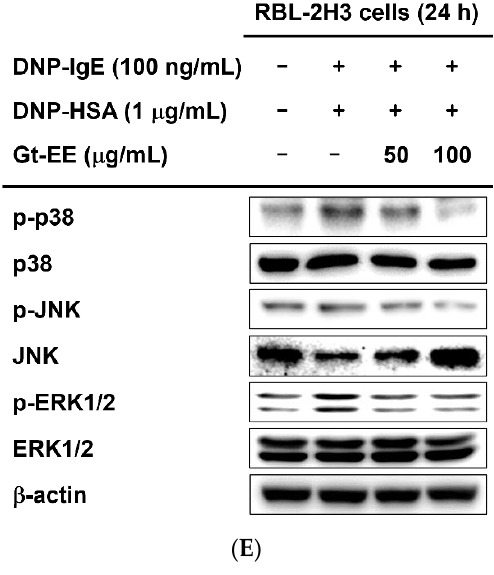
Figure 2. Gt-EE suppressed the mRNA expression of allergic cytokines and activation of the IgE – FcεRI signaling pathway. ( A,B ) The mRNA expression levels of IL- 1β, IL -4, IL-5, IL-6, IL-13, TNF- α, MCP -1, TSLP, and TGF- β1 in IgE-stimulated RBL-2H3 cells were investigated using real-time PCR. IgE-sensitized RBL-2H3 cells were treated with Gt-EE for 30 min and then challenged with DNP-HSA for 24 h. ( C – E ) The total or phosphorylated forms of Syk, PLCγ1, PKCδ, PI3K, AKT, NF - κB p65 , NF- κB p50, p38, JNK, and ERK1/2 in IgE -stimulated RBL-2H3 cells were detected using an immunoblotting analysis. IgE-sensitized RBL-2H3 cells were treated with Gt-EE for 30 min and then stimulated with DNP-HSA for 24 h. ( A , B ) The results are expressed as mean ± standard deviation. ## p < 0.01, ### p < 0.001 compared with the normal group, and * p < 0.05, ** p < 0.01, *** p < 0.001 compared with the control group.